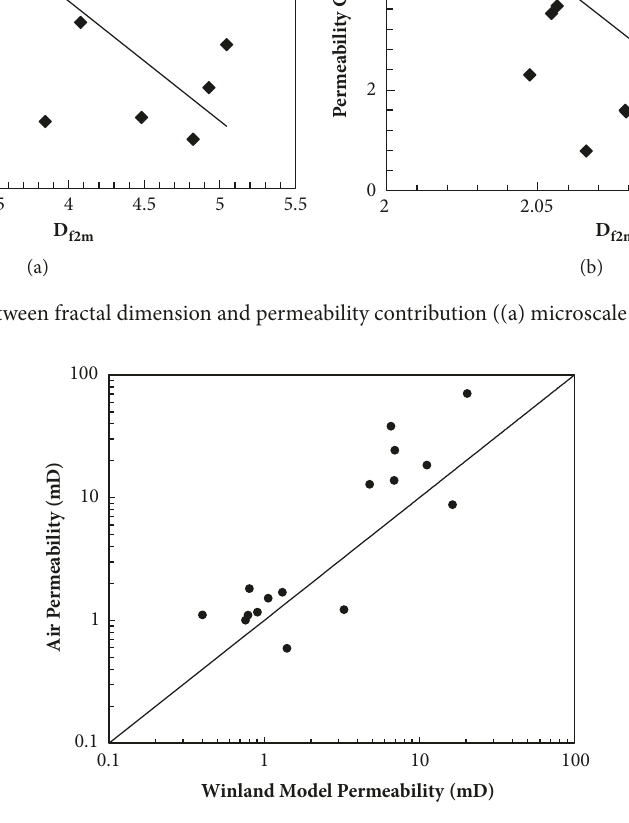
Figure 14: Comparison between the measured air permeability and the calculated permeability using Winland permeability